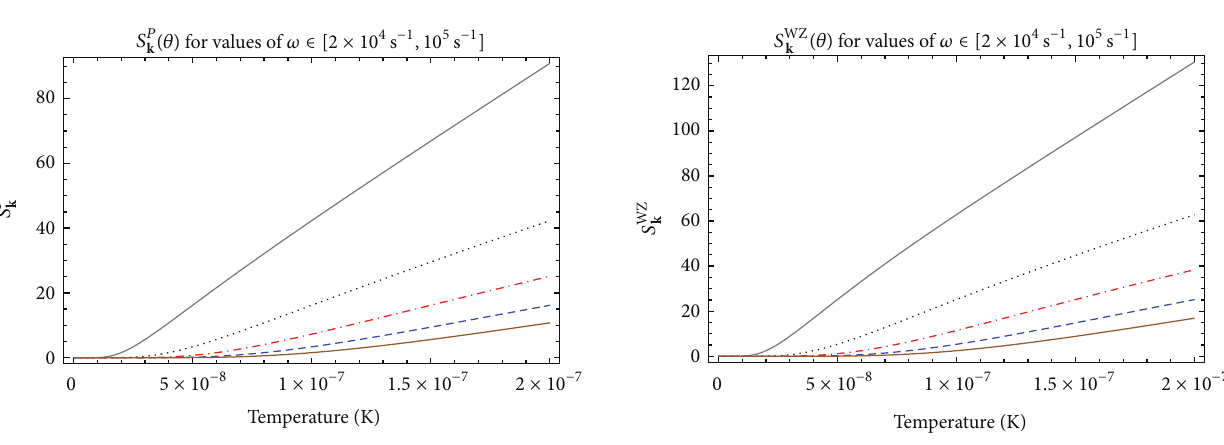
Figure 3: Plots of the total AAI induced by SUSY breaking, 𝑆 WZ k as a function of temperature 𝑇 , for the same time interval and sample values of 𝜔 as in Figures 1 and